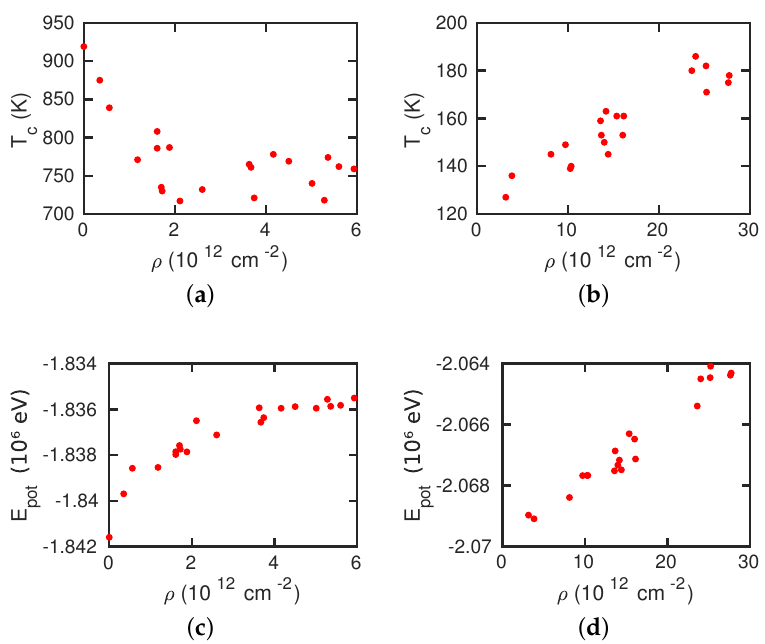
Figure 2. Transition temperature T c as a function of the dislocation density ρ for the ( a ) austenitic and ( b ) martensitic transformations; potential energy of the crystallites E pot as a function of the dislocation density ρ for the ( c ) bcc and ( d ) fcc